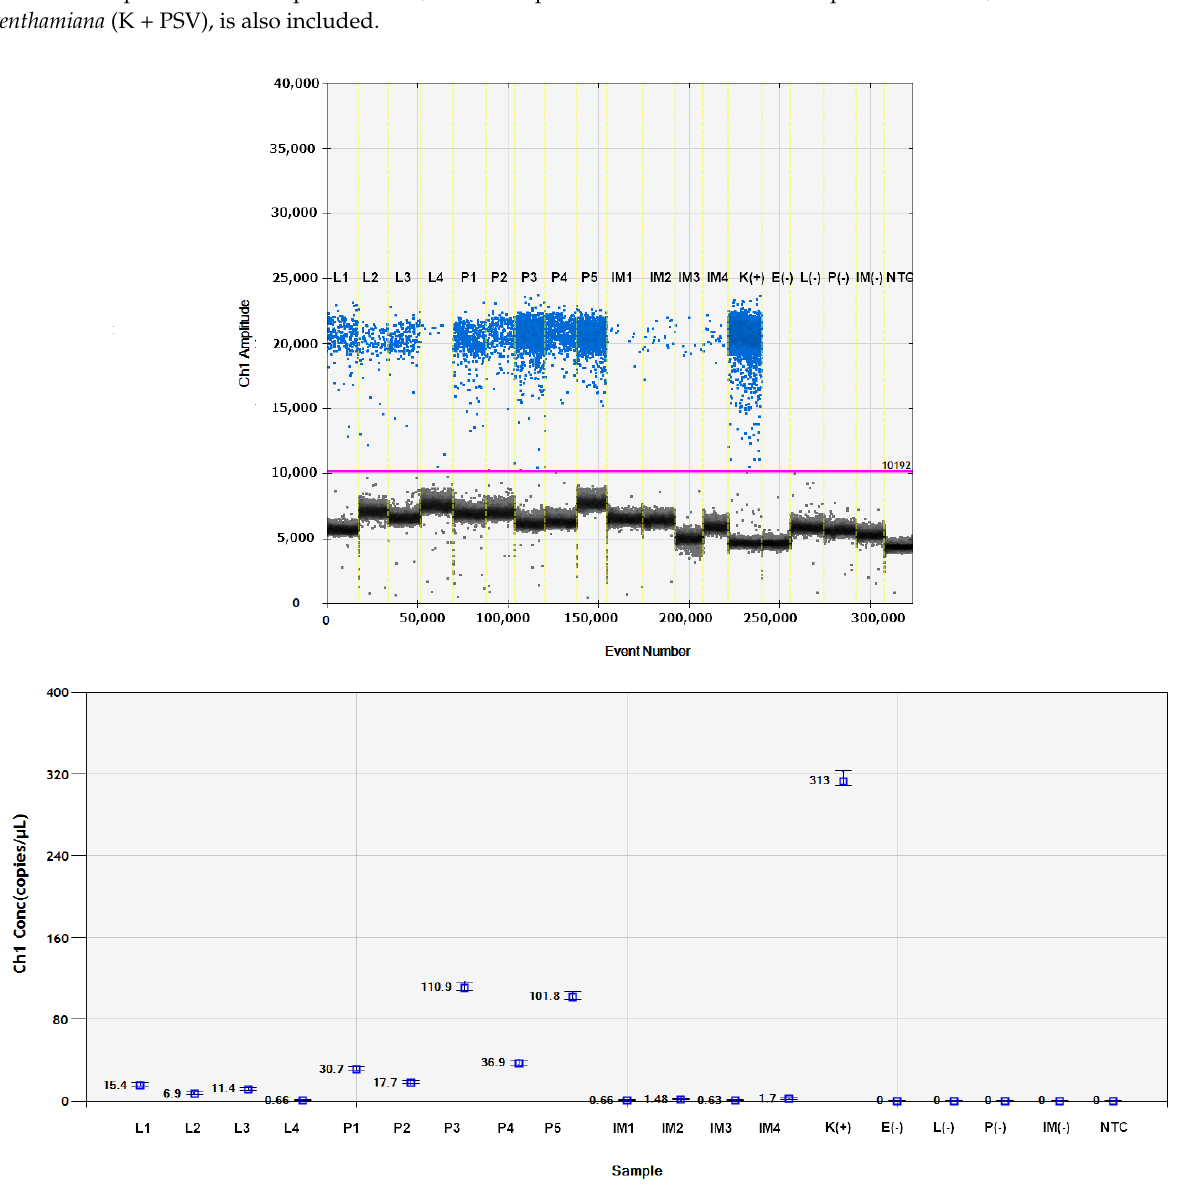
Figure 4. Detection of PSV 1a gene in the subsequent developmental stages of B. impatiens using EvaGreen digital droplet PCR approach. ( Upper ): 1-D plot diagram presents differences in amplitudes of fluorescence signals between positive and negative droplets. Blue dots: positive droplets with amplification, grey dots: negative droplets with no amplification. Pink line: threshold separating population of negative from positive droplets. ( Below ): the diagram showing the concentration of viral copies per 1 μ L of the reaction mixture. L—larva, P—pupa, IM—adult stage, E—egg from a virus-free B. impatiens colony, ( − )—negative control samples: PSV-non-exposed, NTC—no template control, K(+) —positive control, N. benthamiana plants infected with PSV inoculum.